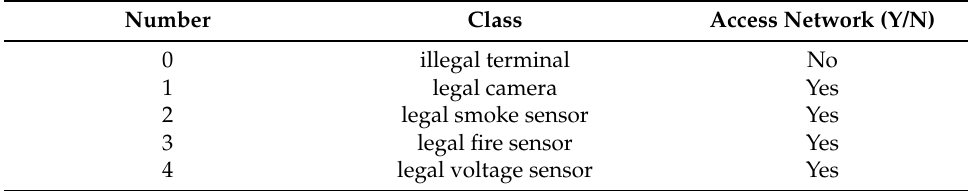
Table 1. Output examples and the corresponding network access